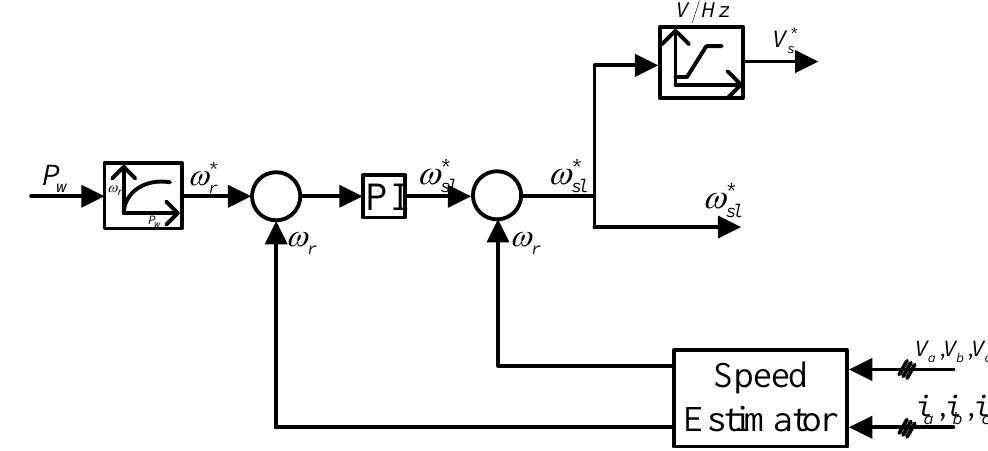
Figure 9. Look up table-based torque estimation